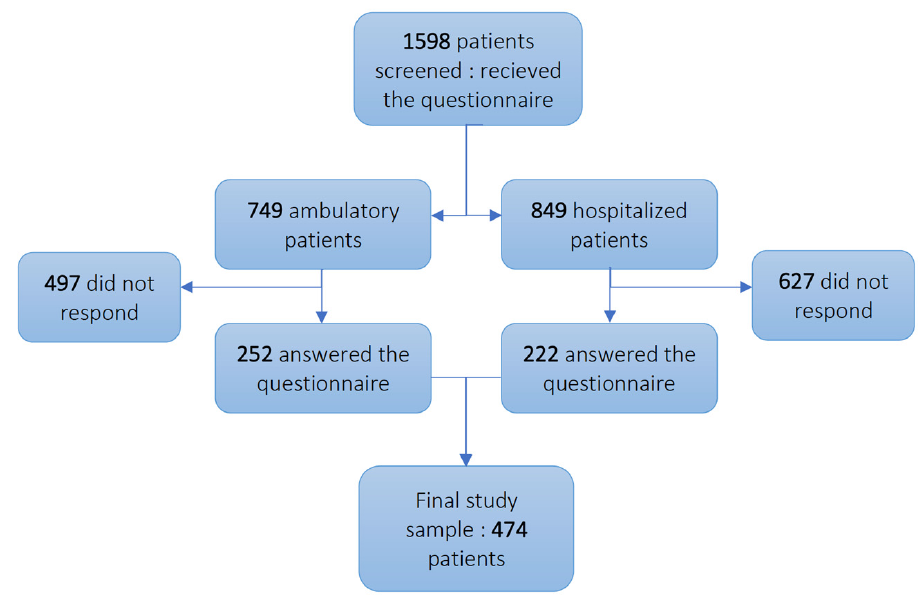
Figure 1. Flowchart of the study population.